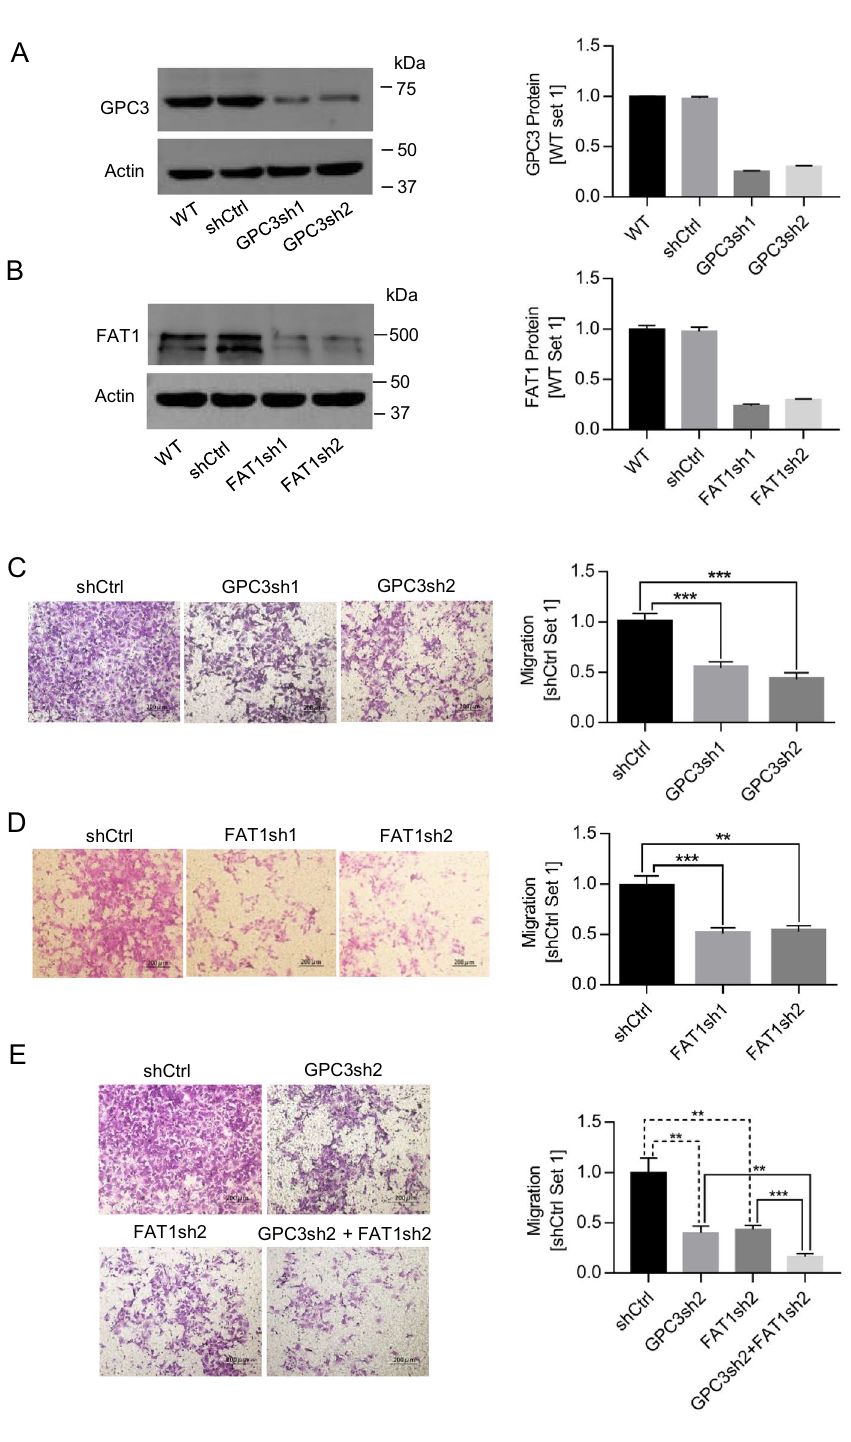
Figure 5. Involvement of GPC3 and FAT1 in HCC cell migration. ( A ) Knock-down of GPC3 in Hep3B cells by stably transfection with GPC3 specific shRNA (GPC3sh1 and GPC3sh2) or control shRNA (shCtrl). Full-length blots/gels were presented in Supplementary Figure S5A. ( B ) FAT1 knock-down. Full-length blots/ gels were presented in Supplementary Figure S5B. ( C ) Migration of Hep3B cells after GPC3 knock-down. Migration assays were performed by using Transwell method. The staining of migrated cells was recorded by taking photographs and cell migration was calculated by the difference of migrated cells between the control and treatment group (n = 3/group). ( D ) Migration of Hep3B cells after FAT1 knock-down. ( E ) Migration of Hep3B cells after GPC3 and FAT1 double knock-down. Data represent mean ± SEM (n = 3). ** P < 0.01; *** P <